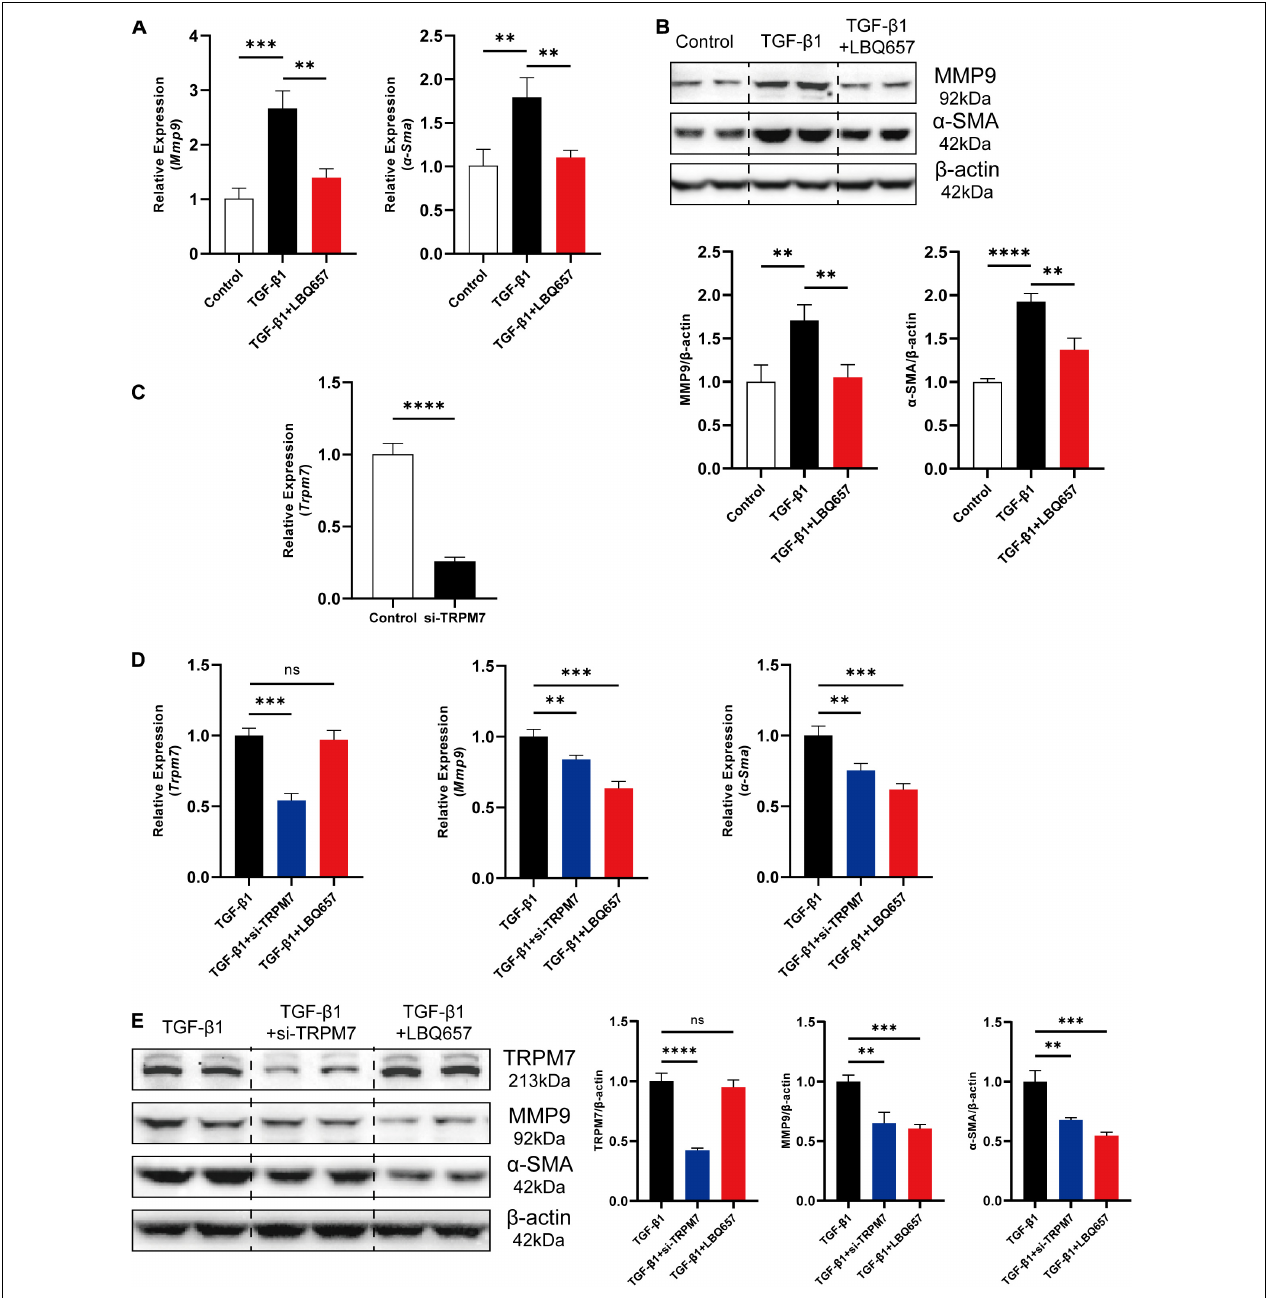
FIGURE 2 | LBQ657 significantly extenuated TGF- β 1 induced cardiac fibroblast activation in MEF. (A) mRNA expression of Mmp9 and α -Sma in control MEF, MEF treated with TGF- β 1 and MEF treated with LBQ657 + TGF- β 1. (B) Protein levels of MMP9 and α -SMA in the rats. (C) The efficiency of the siRNA used to reduce the mRNA expression of TRPM7 in MEF. (D) mRNA expression of Trpm7 , Mmp9 and α -Sma in MEF treated with TGF- β 1, MEF transfected with si-TRPM7 and treated with TGF- β 1, MEF treated with LBQ657 + TGF- β 1. (E) Protein levels of TRPM7, MMP9 and α -SMA in the rats. The data presented are mean ± SD. Each group contained the results of three independent repeated trials. 18S RNA was used as the internal reference gene and β -actin was used as the internal reference protein for normalization and statistical analysis. ∗∗∗∗ P < 0.0001, ∗∗∗ P < 0.001, and ∗∗ P < 0.01.